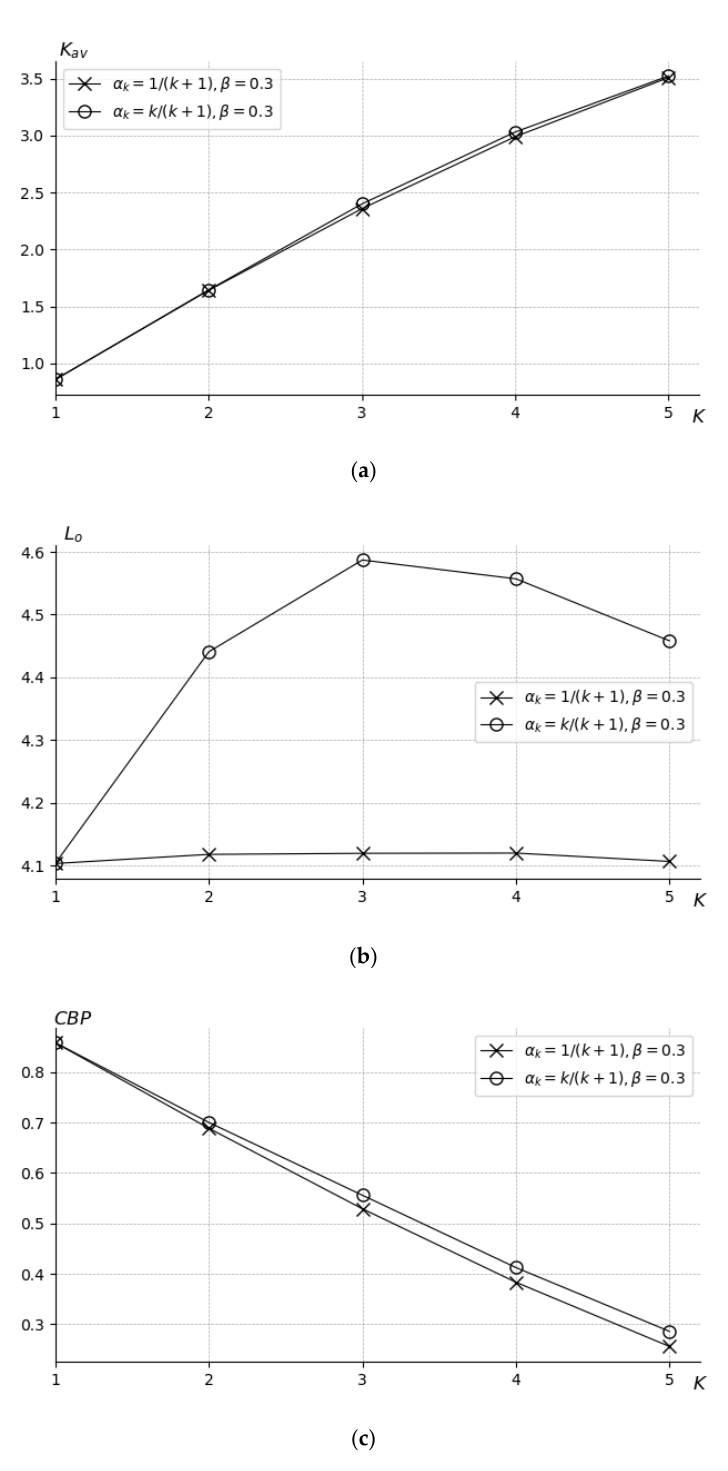
Figure 5. Dependency K av ( a ), L o ( b ) and CBP ( c ) on K for state-dependent feedback probabilities.